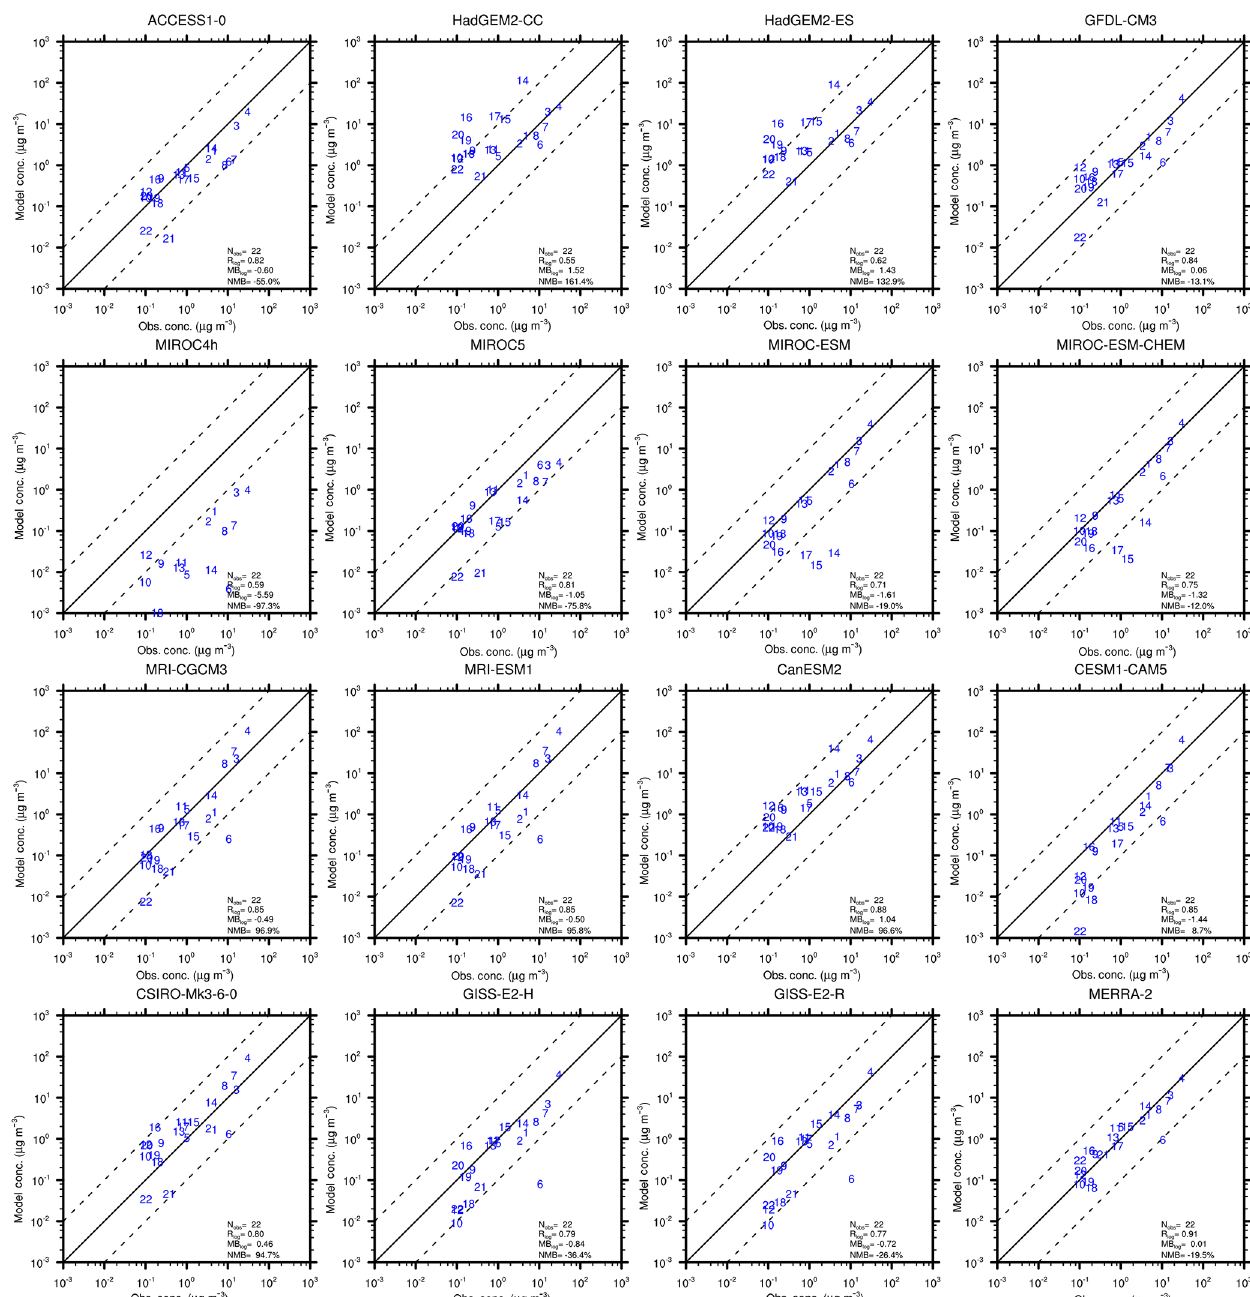
Figure 9. Scatter plot of surface dust concentration at 22 selected stations between models and observations. The stations are indexed in Table 2 and their locations are shown in Fig. 1. Also given are the correlation coefficients and mean bias between models and observations (after taking the logarithms; R log and MB log , respectively). The normalized mean bias (NMB) that is calculated from the mean bias divided by mean observations is given as well. The 1 : 1 (solid) and 1 : 10 / 10 : 1 (dashed) lines are plotted for reference. The comparison results for some stations (nos. 15–17 and nos. 19–22 for MIROC4h; no. 21 and no. 22 for MIROC-ESM and MIROC-ESM-CHEM) are not shown as they are located too low and outside the